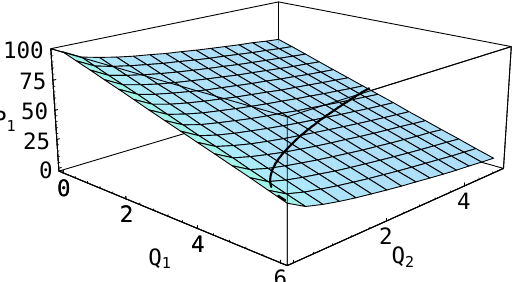
Figure 2. A ‘demand surface’ with consumption externalities in a 2-variant setting When the consumption of the luxurious good Q increases, the benefits of consumption of 2 good 1 decrease. This can reflect that the variant 1 is becoming less attractive, relative to the average product quality (i.e., variants 1 and 2 together). In the case of automobiles, a smaller vehicle yields smaller benefits when an increasing number of larger and faster cars use the road. As a result, the demand curve for good 1 shifts down when Q increases. In this way, 2 we can construct the three-dimensional demand surface depicted in Figure